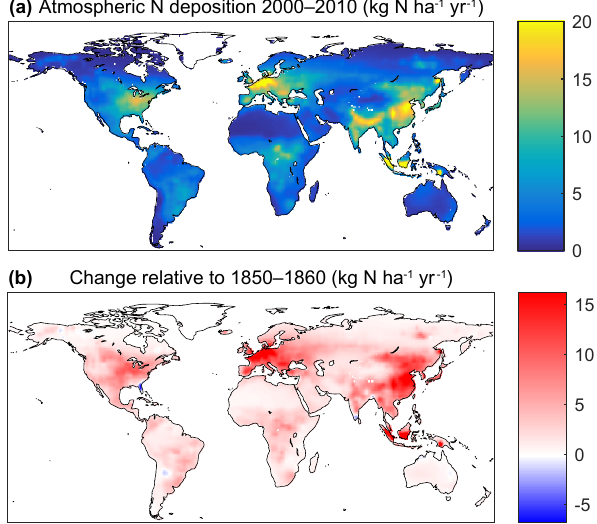
Figure 1. Atmospheric N deposition for 2000–2010, the last decadal interval of the ACCMIP historic N deposition data set (Lamarque et al., 2013). (a) Absolute rates. (b) Change relative to 1850–1860. For both figures the colour axis is cut off at approxi- mately the 99% quantile to improve